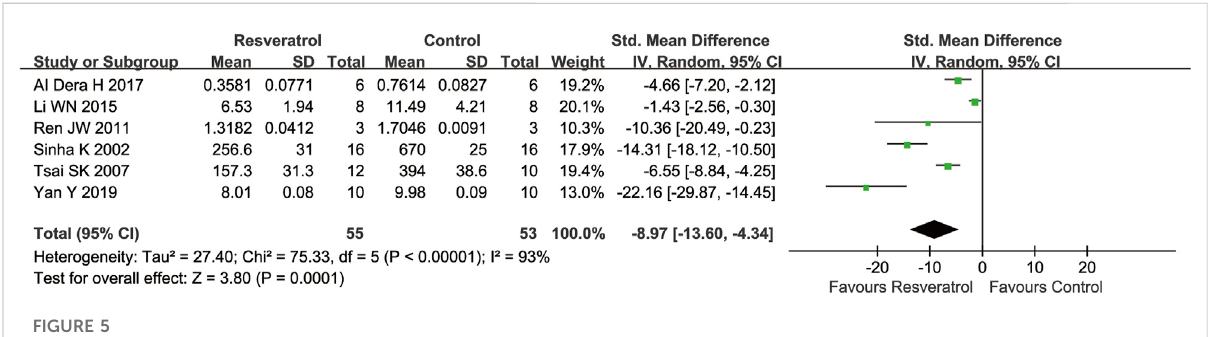
FIGURE 5 Meta-analysis of resveratrol for MDA in rats after cerebral I/R